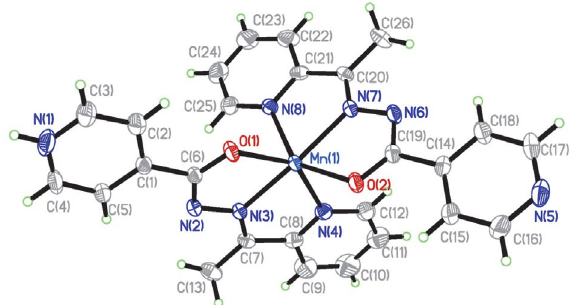
Fig. 3. Perspective view of complex 2 with 30% probability thermal